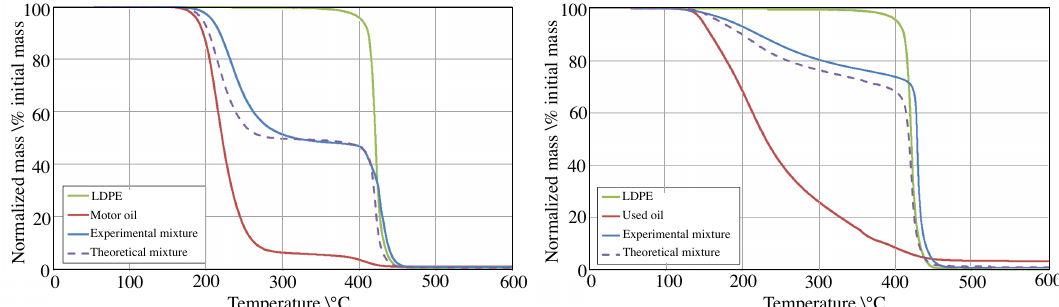
Figure 1. Thermogravimetric analysis of LDPE, motor oil, used oil and the two mixtures of oil and plastic, with a heating rate of 10 ◦ C · min − 1 . Mass of the sample as a function of the temperature. Left column: mixture of LDPE and motor oil (45 wt% of LDPE). Right column: mixture of LDPE and used oil (67 wt% of LDPE).